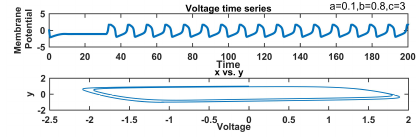
Figure 35. Responses of membrane potential and recovery variables with a = 0.1, b = 1, c =